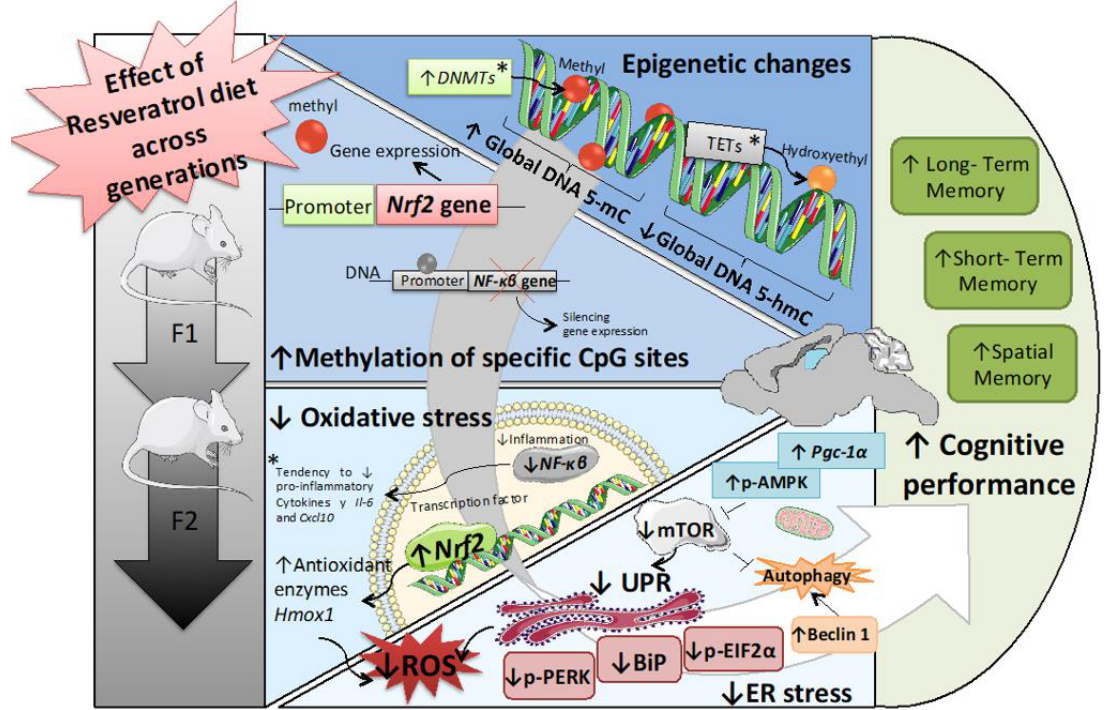
Figure 7. Representative scheme of epigenetic and molecular mechanisms modified in the hippocampus of Senescence-Accelerated Prone Mice (SAMP8) across generations. Significant modifications are shown in bold and potential modifications with the symbol *.